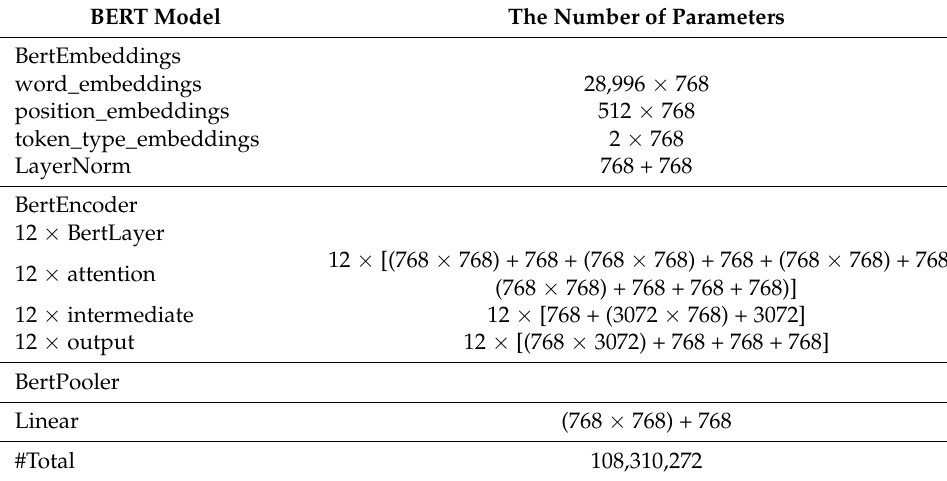
Table 2. The number of parameters of the BERT model.